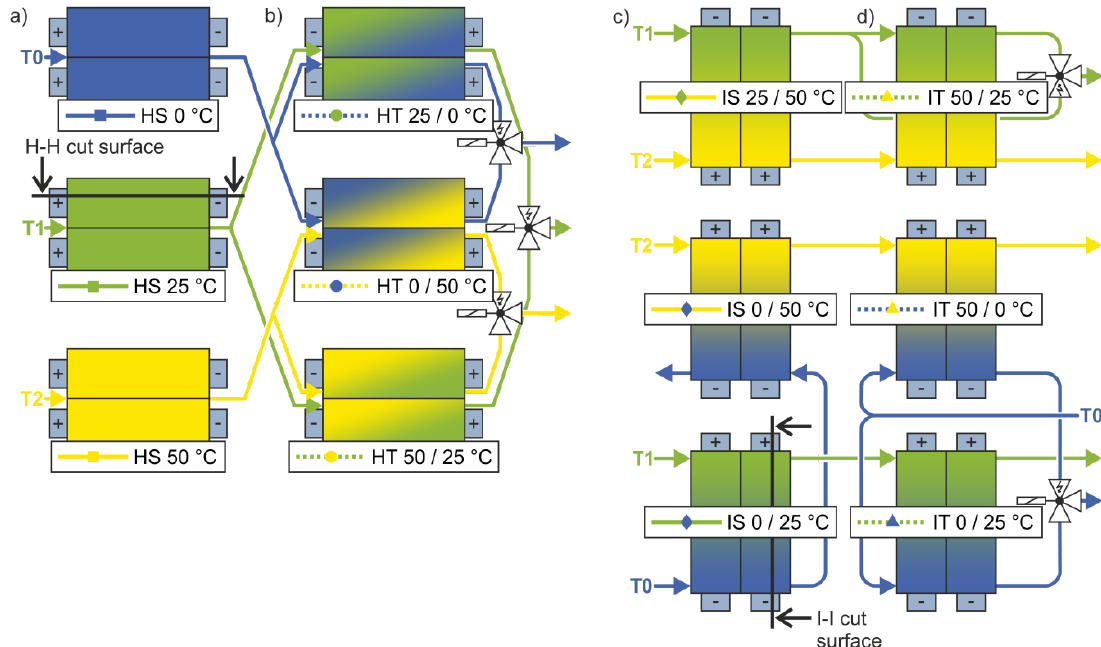
Figure 2. Flow diagrams of the homogeneous ( a ) steady (HS) and ( b ) transient (HT) setups, as well as the inhomogeneous ( c ) steady (IS) and ( d ) transient (IT) setups.